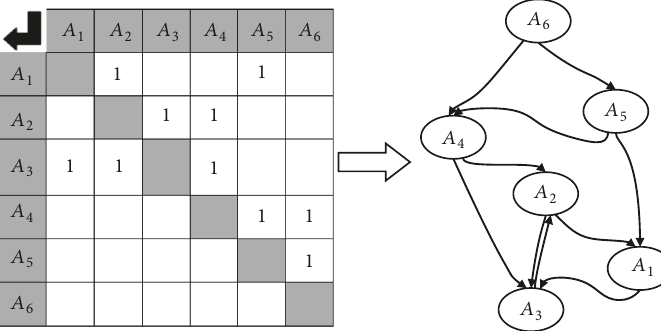
Figure 2: Coupling fault identification between meta-actions.